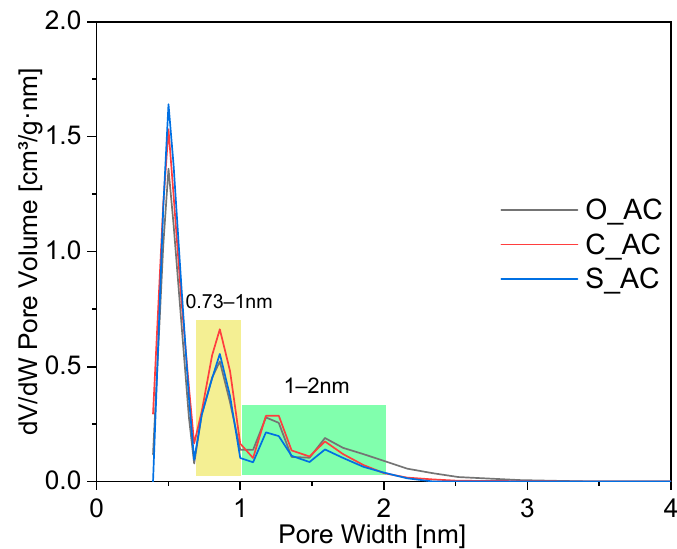
Figure 2. The pore volume distribution for tested activated carbons. Figure 3 illustrates the X-ray diffraction profiles of the O_AC, C_AC and S_AC sam- ples.